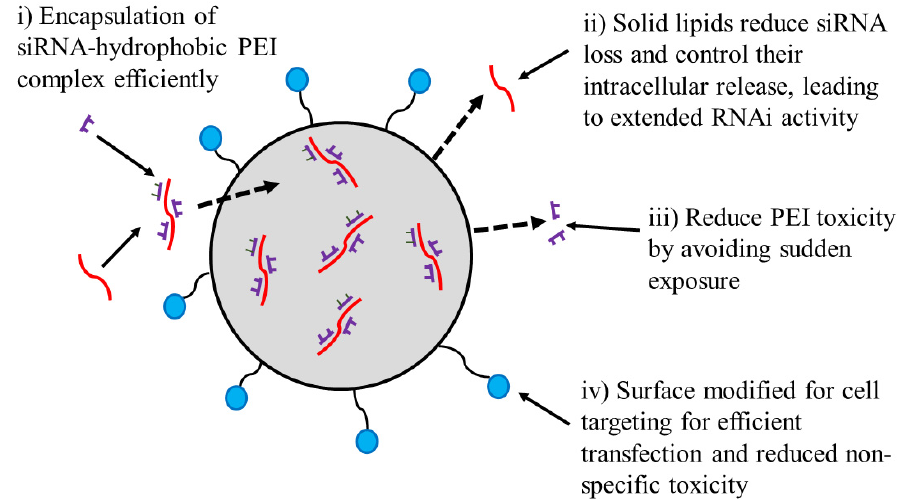
Figure 4. Schematic design and hypothesis of using LPNs for providing targeted, extended, and safer siRNA therapy. siRNA molecules (red) are complexed with hydrophobically modified linear PEI molecules (violet lines) which are then physically encapsulated into the core of a nanocarrier made up of solid lipids (grey). The surface groups represent the targeting moieties, e.g., phospholipids tagged with the folate group (blue).